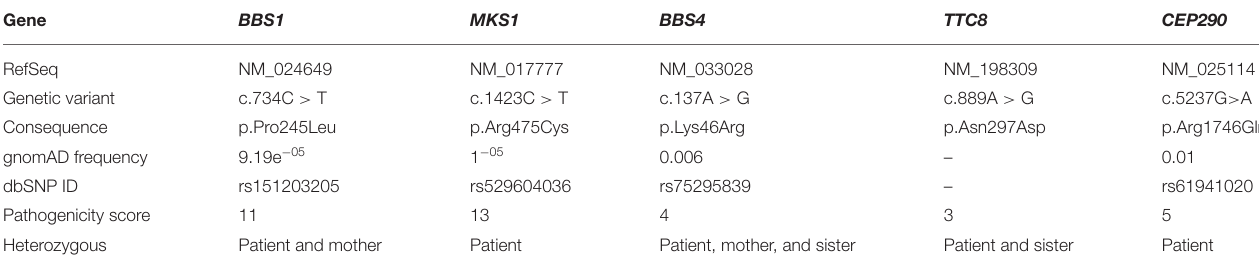
TABLE 1 | List of the rare variants identified in the BBS genes.